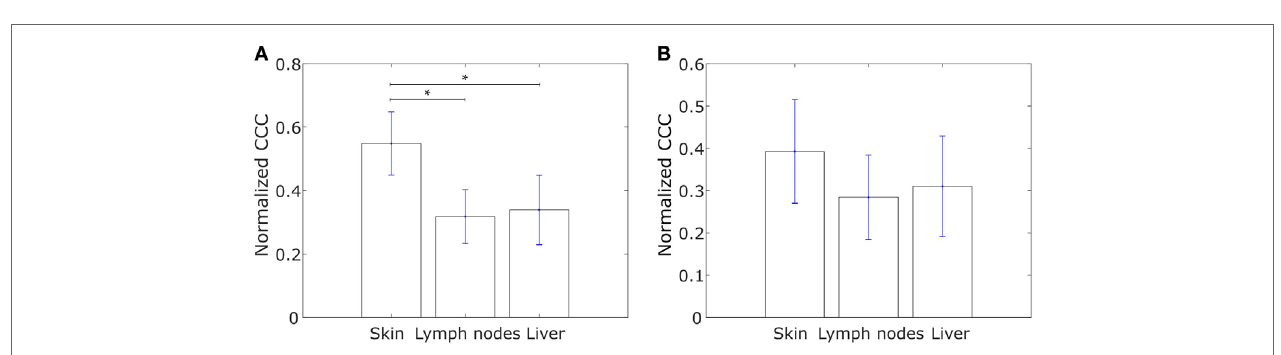
FigUre 7 | Normalized cophenetic correlation coefficient for tumor samples from breast cancer metastases to skin ( n = 17), lymph nodes ( n = 39), and liver ( n = 16): (a) normalized CCC of the collective dissemination-associated gene network and (B) normalized CCC of the IBC-associated gene network. Gene expression data from the study by Kimbung et al. (59). Error bars indicate the SE in the estimate of CCC norm calculated using the bootstrap method. * p -Value < 0.05.